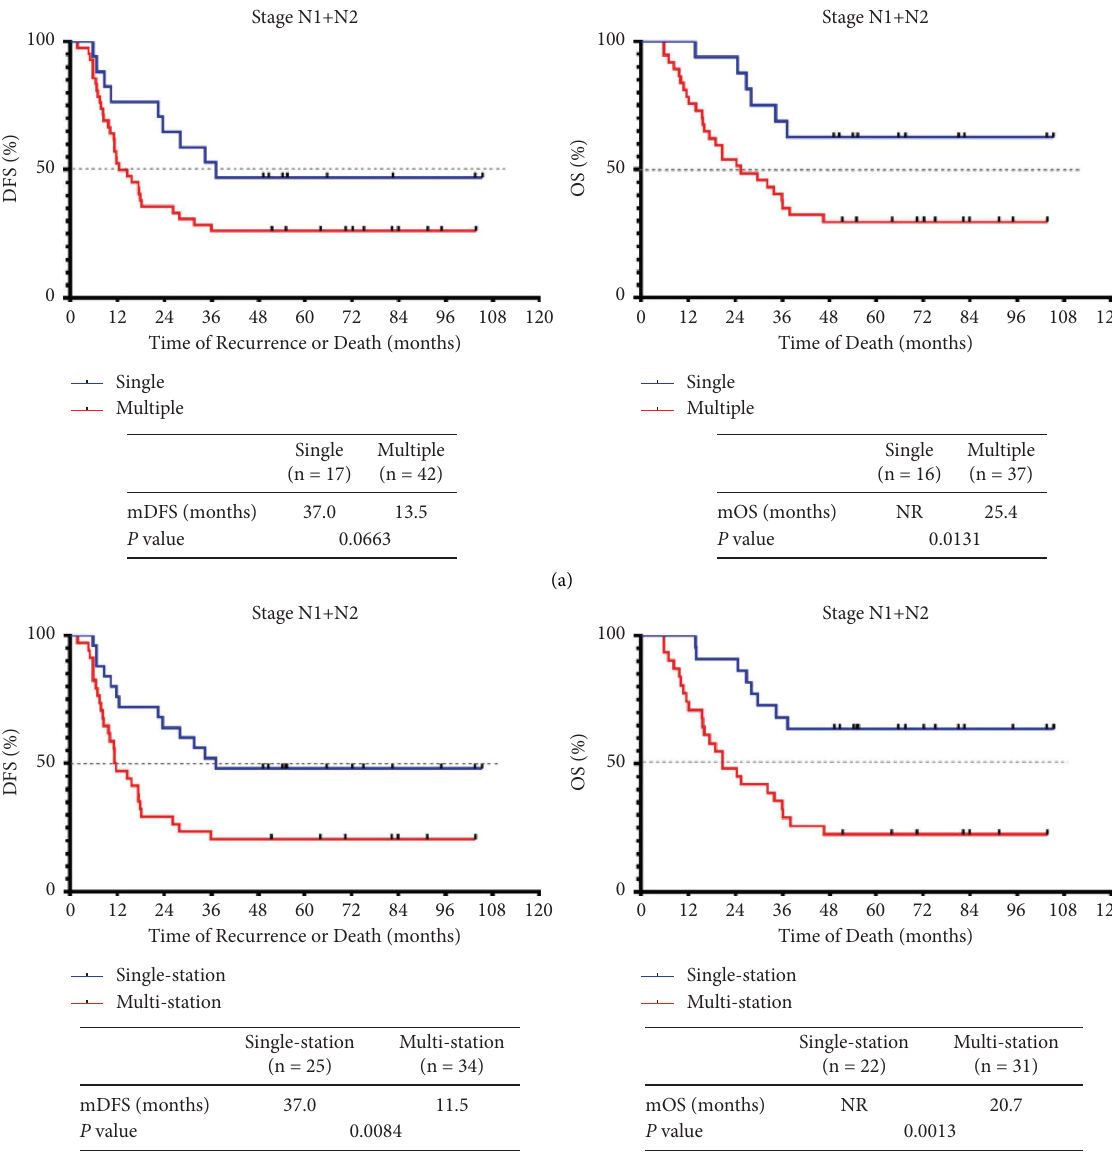
Figure 2: Prognostic utility of lymph node involvement for patients diagnosed with pN-positive SCLC after surgery. (a) Te DFS ( n � 59) and OS ( n � 53) curves of stage pN1 and pN2 SCLC patients after surgery by lymph node involvement (single and multiple lymph node metastases). (b) Te DFS ( n � 59) and OS ( n � 53) curves of stage pN1 and pN2 SCLC patients after surgery by lymph node station involvement (single- and multistation lymph node